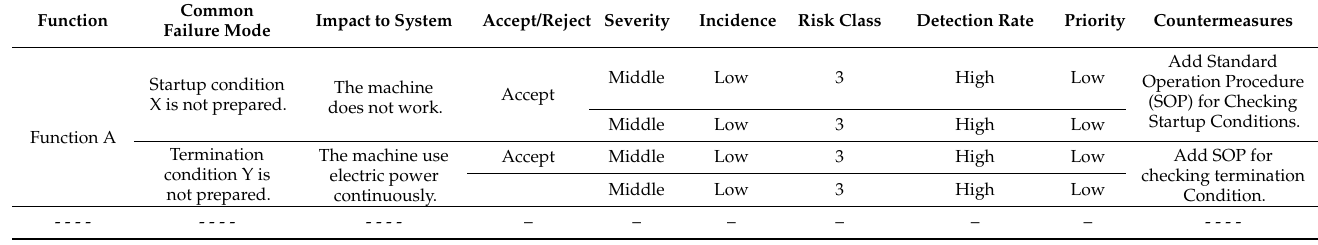
Operation Procedure